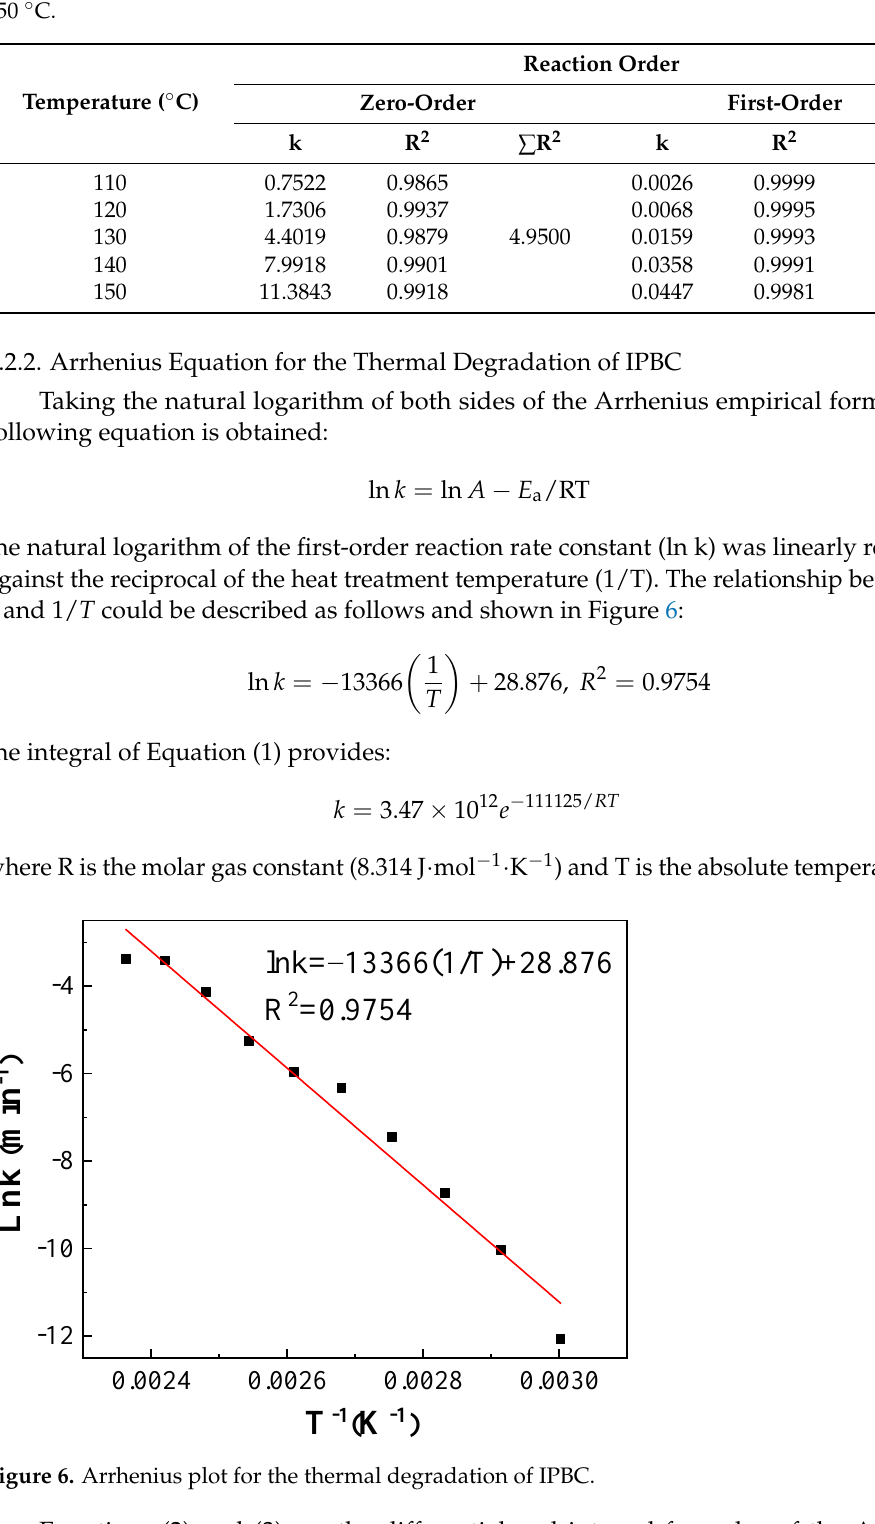
Figure 6. Arrhenius plot for the thermal degradation of